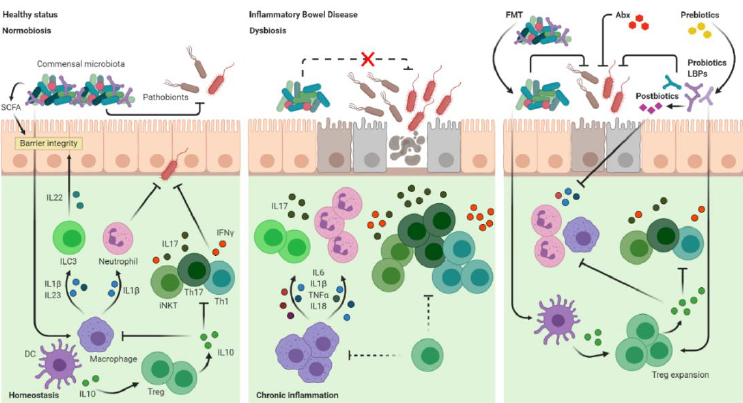
Figure 1. Homeostatic and pro-inflammatory role of the gut microbiota and microbe-targeted therapies for IBD management. During homeostasis (left panel), the recognition of specific PAMPs from the gut microbiota induces antigen presenting cells (APCs) like macrophages and dendritic cells (DC) to produce IL1β and IL23. Subsequently, different cell-types such as neutrophils, Th17 and ILC3 cells express cytokines (e.g., IL17 and IL22) that control the expansion of commensals and the potential invasion of microbes that could be harmful (pathobionts). The production of short-chain fatty acids (SCFAs), by the gut microbiota, in concert with IL22, enhances intestinal epithelial cell barrier function. Furthermore, commensals such as bifidobacteria, PSA+ B. fragilis and Clostridium spp. stimulates APCs to promote anti-inflammatory IL10 Treg responses regulating iNKT, Th1 and Th17 responses. In inflammatory bowel disease (IBD) (central panel) a combination of genetic and environmental factors lead to depletion of protective bacteria and the enrichment of colitogenic pathobionts, resulting in chronic inflammation due to hyper-activation of T helper 1 (Th1) and Th17 cells as well as aberrant innate, pro-inflammatory responses. Dashed lines show impaired responses. The use of microbe-targeted therapies (right panel) to restore homeostatic immune responses contribute to the expansion of anti-inflammatory responses by Treg cells and the modulation of pro-inflammatory cytokines release.